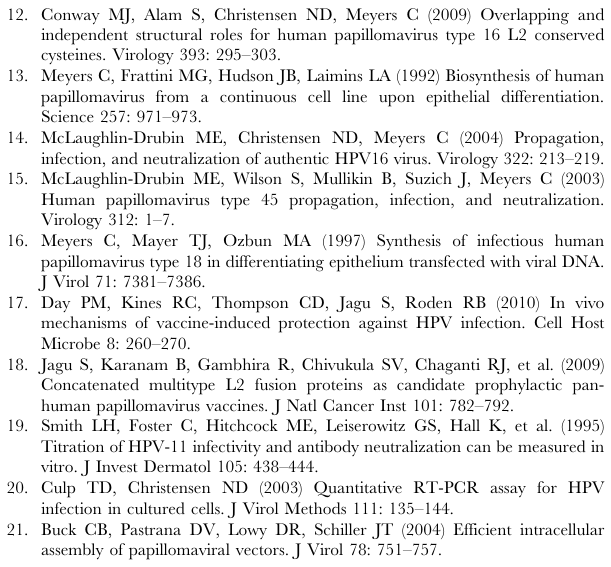
Table S3 Characteristics of anti-HPV16 L2 external loop-targeting